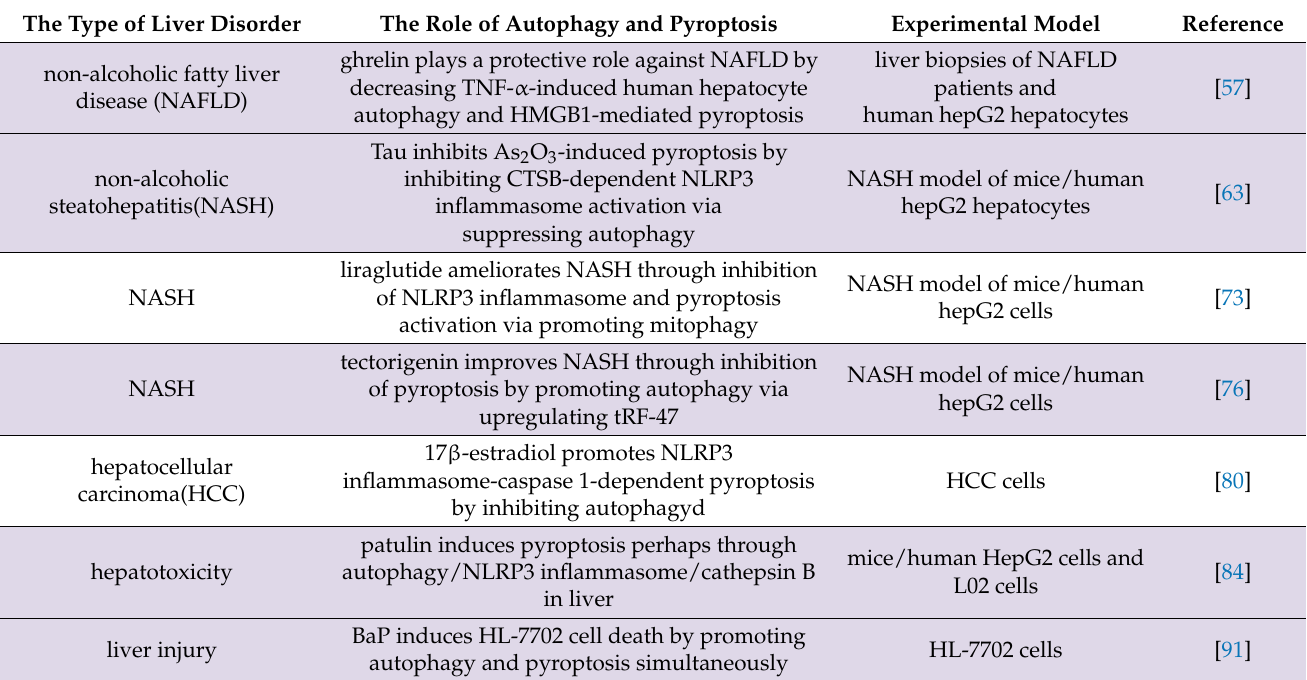
Table 1. The summary of the role of autophagy and pyroptosis in liver